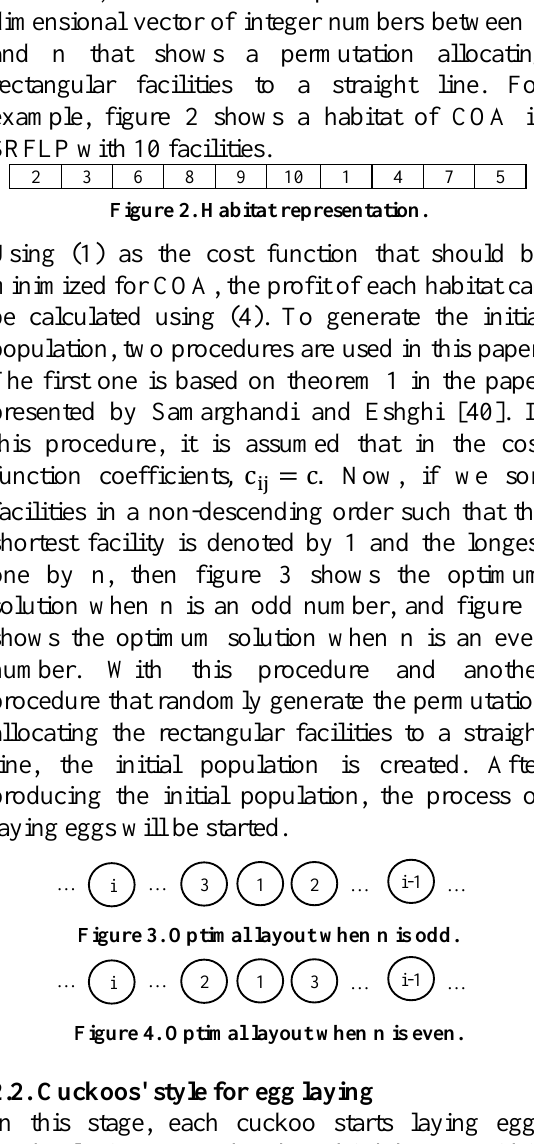
Figure 2. Habitat representation.